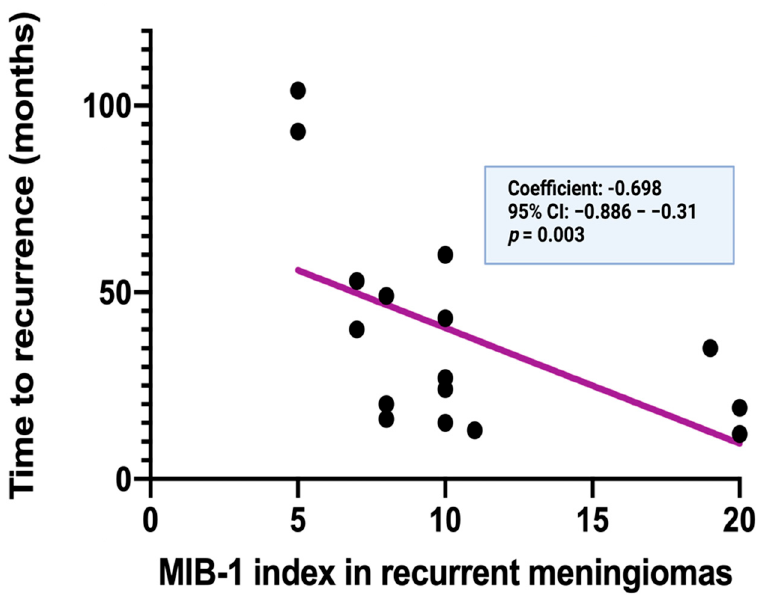
Figure 5. Time to recurrence (in months) in relation to the MIB − 1 labeling index of the 16 corre- sponding recurrent cranial meningiomas.